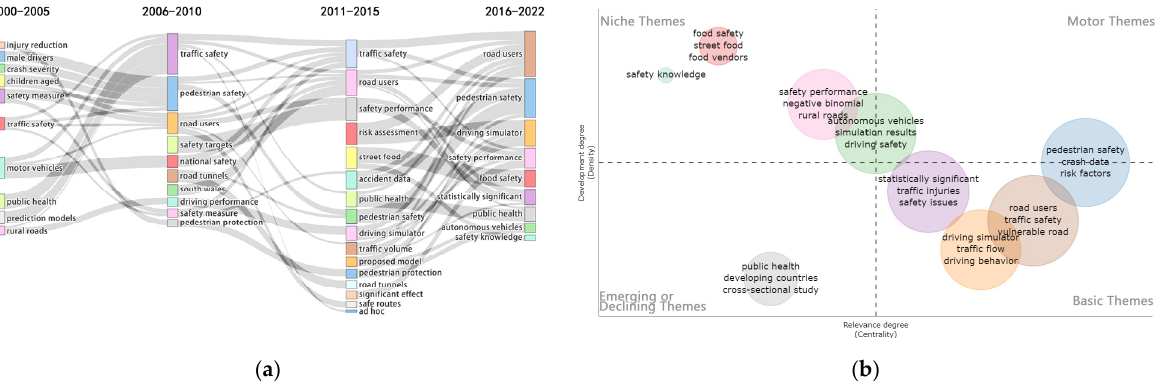
Figure 2. Trend of street safety research: ( a ) thematic evolution of street safety research, ( b ) thematic map of street safety research.